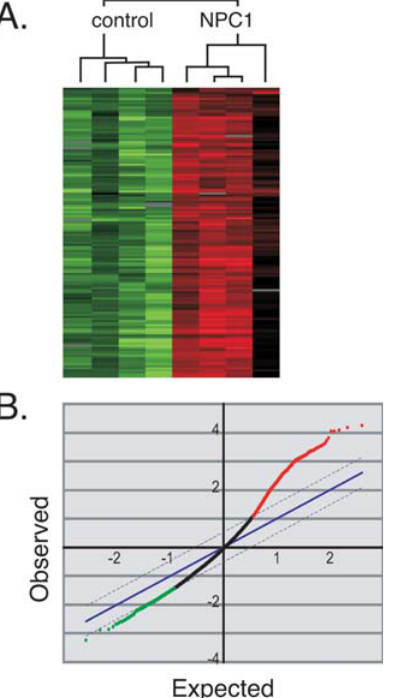
Figure 1. Gene expression is significantly altered in NPC1 fibroblasts. (A) Supervised hierarchical clustering of the top 200 genes after SAM analysis. The dendrogram at the top shows clustering of NPC and control fibroblasts into distinct groups. Genes with higher expression are shown in red; genes with lower expression are shown in green. Gray bars indicate missing data. Cell lines clustered in the following order (left to right): control lines AG10803, GM05659, GM09503, GM03726; NPC-1 lines GM017909, 59413, 83.16, and GM18453. (B) Significance Analysis of Microarrays [12] was used to identify genes that varied in expression between NPC fibroblasts and control fibroblasts from healthy patients. The plot of the data from 43,000 elements reveals approximately 3600 significant genes that have increased expression in NPC fibroblasts (shown in red).